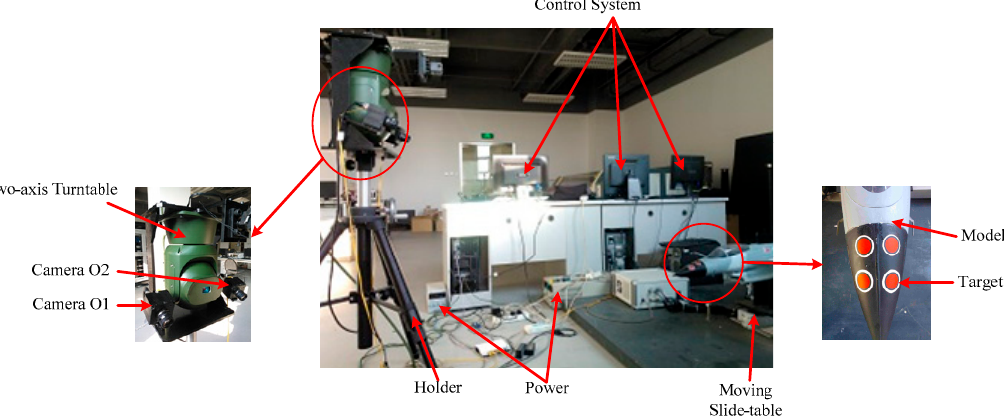
Figure 1. The physical experimental system. The target to be tracked is a red round sticker attached to the model.